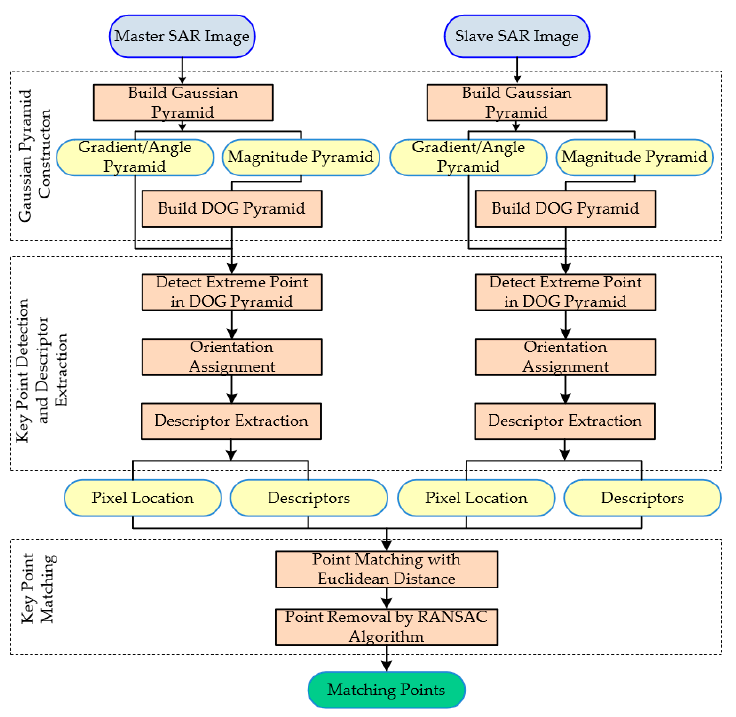
Figure 5. Diagram of SAR + SIFT + RANSAC processing flow.